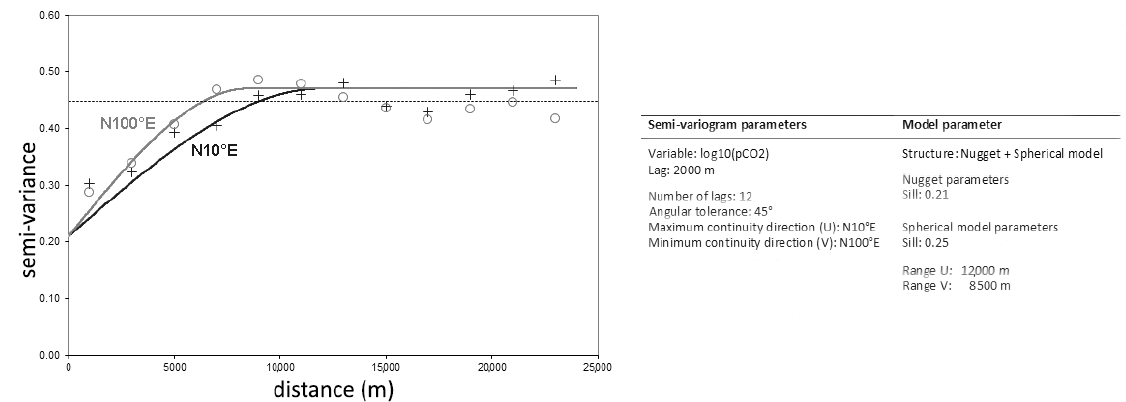
Figure 4. Experimental semi-variogram of the log-transformed p CO 2 data.